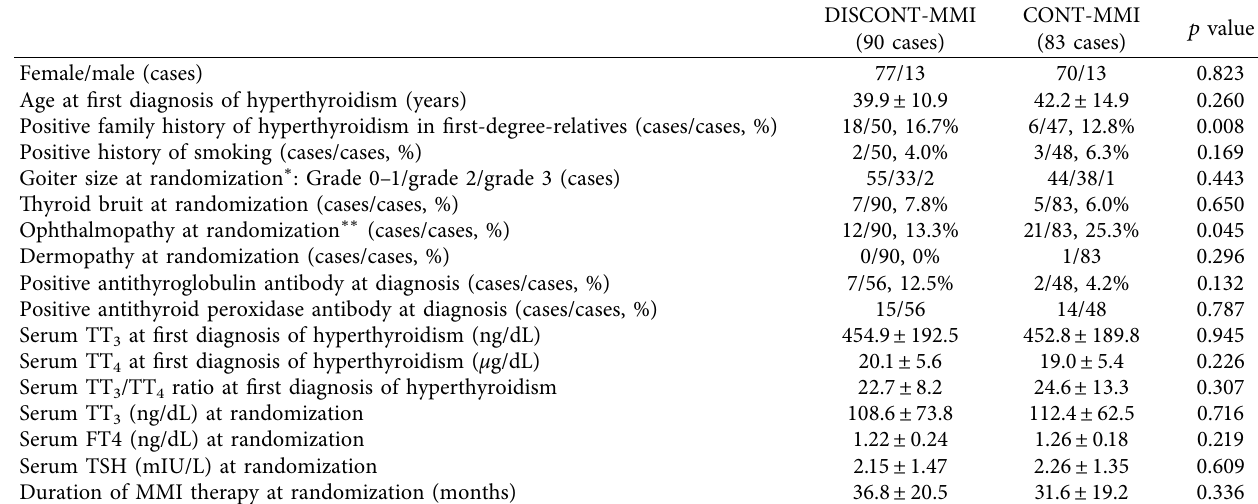
Table 1: Baseline clinical and biochemical characteristics of 173 Graves’ hyperthyroid patients who were randomly assigned to discontinue and continue low-dose methimazole